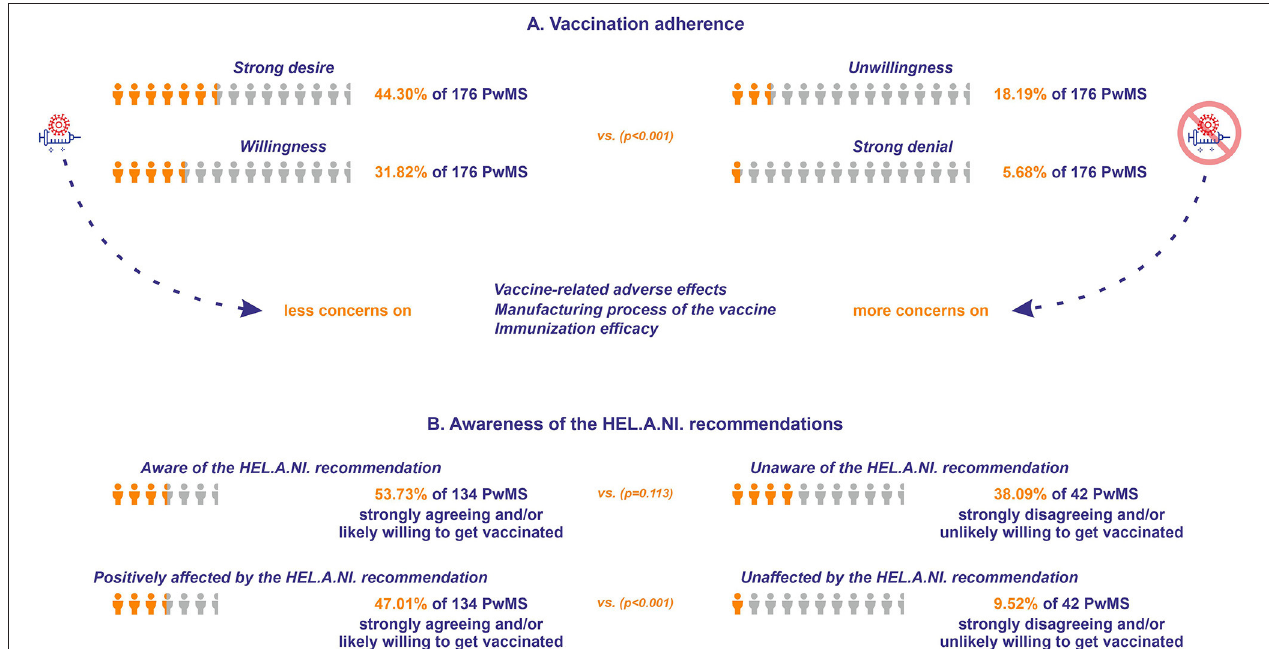
FIGURE 5 | (A) Vaccination adherence for the respondents of Questionnaire B. The orange icon of human form depicts the percentage of the respondents strongly agreeing or likely willing to get vaccinated (vs. those strongly disagreeing or unlikely willing), while the light gray icon depicts the total number of PwMS who responded to the questionnaire. (B) Awareness of vaccination recommendations for the respondents of Questionnaire B. The orange icon of human form depicts the percentage of the respondents who were aware of the Hellenic Academy of Neuroimmunology (HEL.A.NI.) recommendation (vs. those unaware), and the respondents who were positively affected by the HEL.A.NI. recommendation (vs. those who were unaffected). The light gray icon depicts the sum of the respondents strongly agreeing and/or likely willing, and the sum of the respondents strongly disagreeing and/or unlikely willing to get